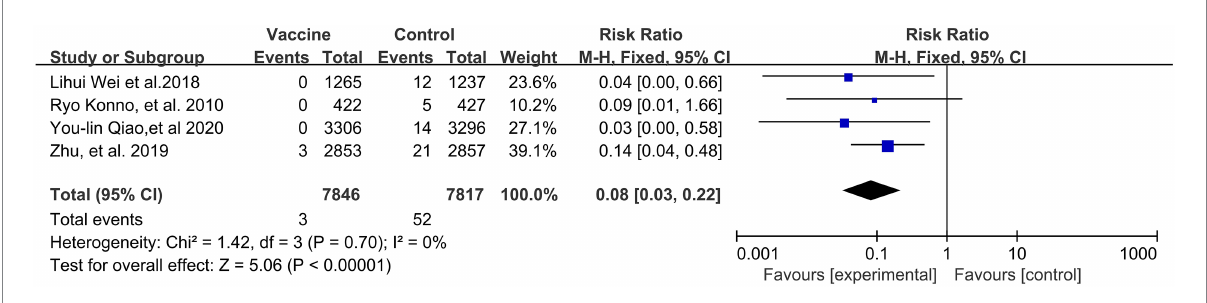
FIGURE 3 A forest plot of the meta-analysis of the incidence of HPV 16/18 associated CIN1+ after HPV vaccination.